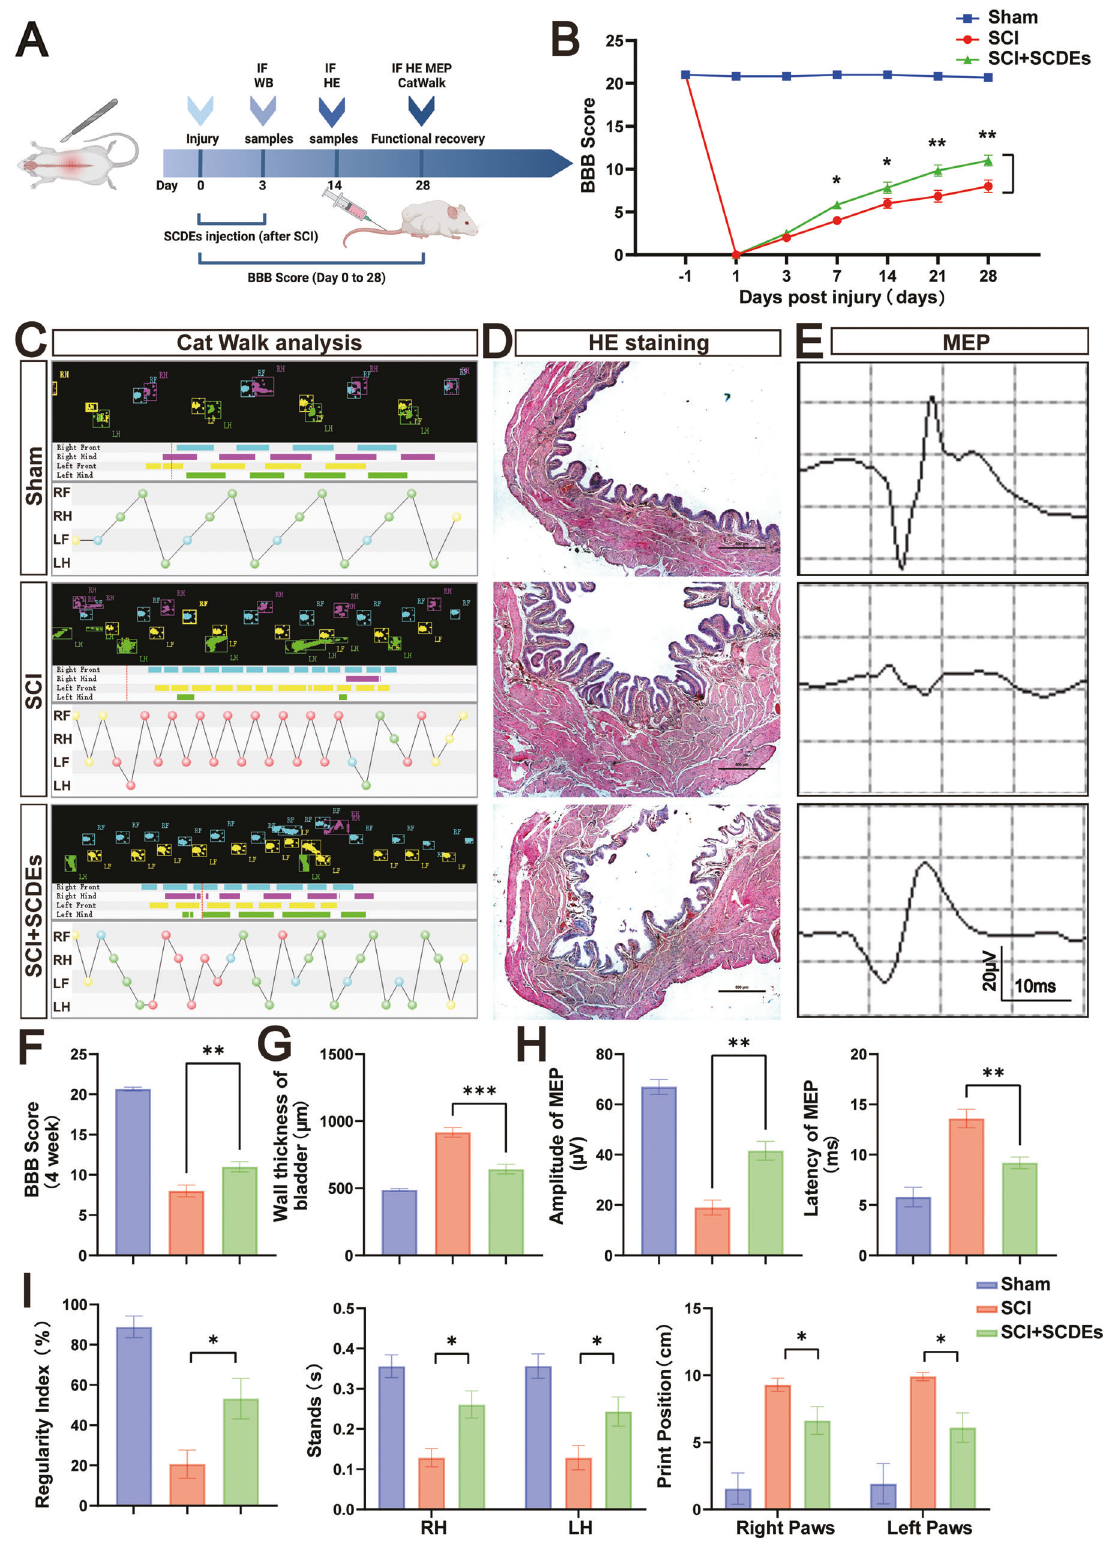
Fig. 3 Function recovery of rats by SCDEs after SCI in vivo. A The Flow chart of animal experiments. B , F The BBB scores of Sham, SCI group, and SCI rat group treated with SCDEs ( n = 5). C Representative paw step images and limbs ’ supporting timing view of CatWalk gait analysis. D The H&E staining of the bladder showed a lesser thickness of the bladder in the SCI rat treated with SCDEs. Scale bar: 500 μ m. E , H Analysis of motor evoked potential (MEP) was performed as an electrophysiological assessment in both groups at day 28 post-injury in both groups ( n = 5). G The wall thickness of the bladder in each group, showing that the bladder function recovered faster in the SCDEs treatment group ( n = 5). I Quantitative analysis of catwalk at day 28 post-injury, including regularity index, print position, and stances of the hindlimb ( n = 5, RH: right hindlimb, LH: left hindlimb). Data were presented as mean ±SEM. Results were analyzed by One-way ANOVA. Signi fi cance: * P <0.05, ** P < 0.01, *** P <0.001. Cell Death and Disease (2023)